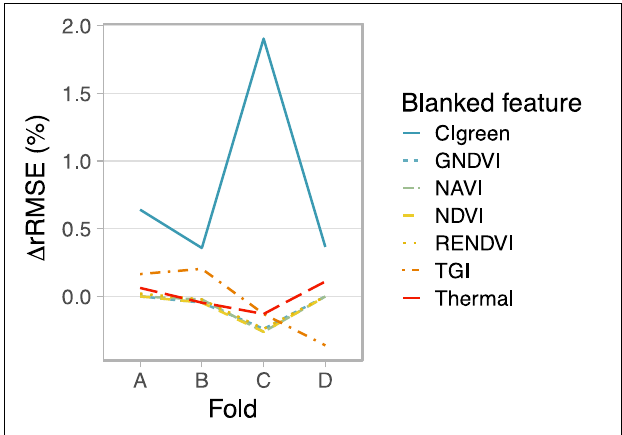
FIGURE 5 | Feature importance for model training on images from 01 Aug 2019. To blank observed variation in a feature, actual values were replaced by the mean value across all pixels observed for that feature. (cid:49) RMSE was calculated by subtracting the test set RMSE of the original model with no feature blanked from the blanked feature model. (cid:49) RMSE is given relative to the mean yield ( (cid:49) rRMSE). Larger, more positive (cid:49) rRMSE values indicate higher feature importance for the respective feature.